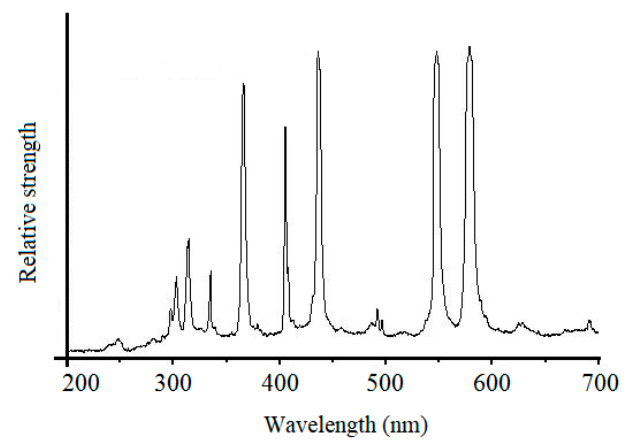
Figure 4. Schematic diagram of the adsorption and polishing experiments. ( a ) Nanoparticle colloid jet adsorption and machining; ( b ) UV-induced nanoparticle colloid jet adsorption and machining.